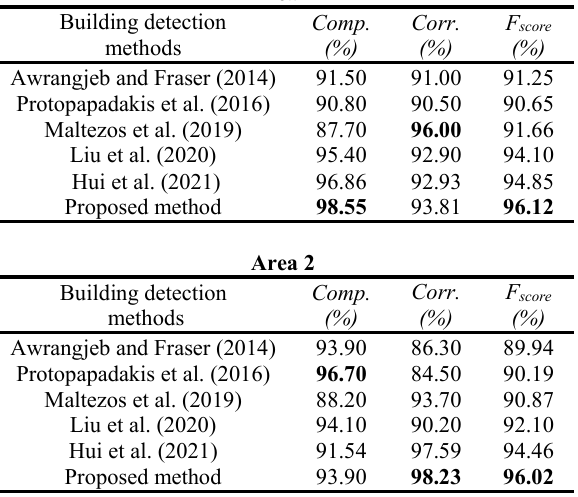
Table 3. Quality parameters estimated for areas 1 and